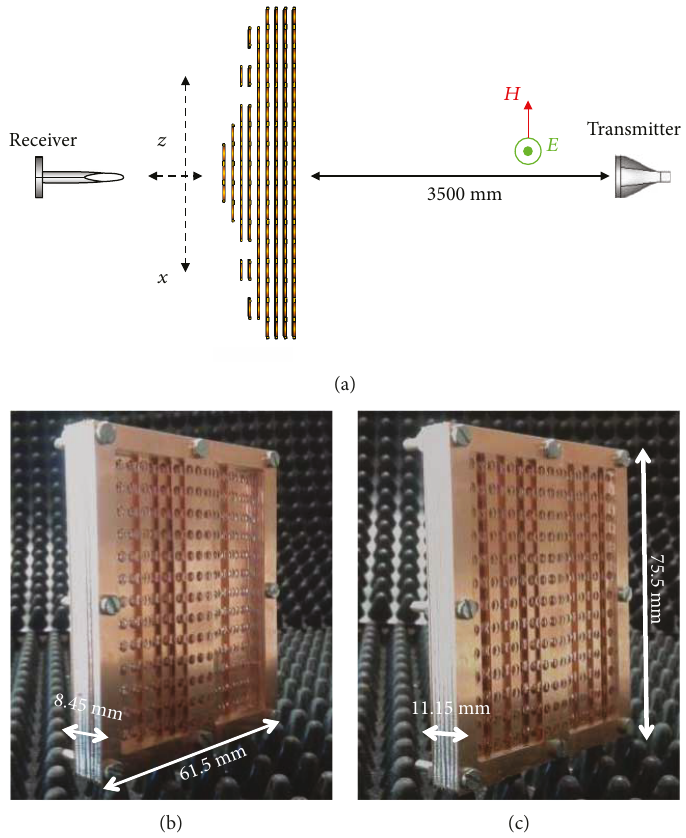
Figure 2: Fabricated prototypes. (a) Sketch of the experimental setup used for characterizing the metalenses. Photographs of the fabricated metalenses with (b) q = 0 and (c) q = 0 35 , both with the phase reversal